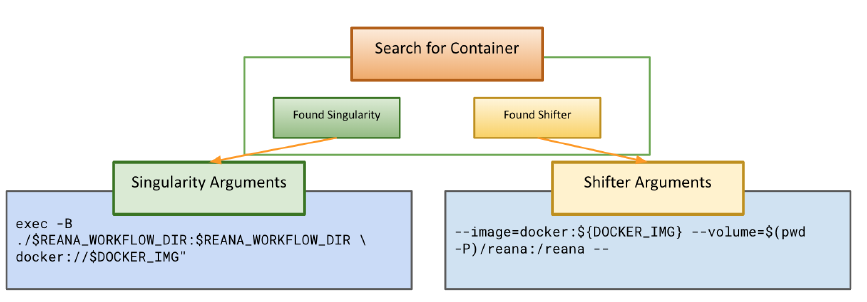
Figure 5. Detection of container technology available in the HPC worker and definition of parameters for